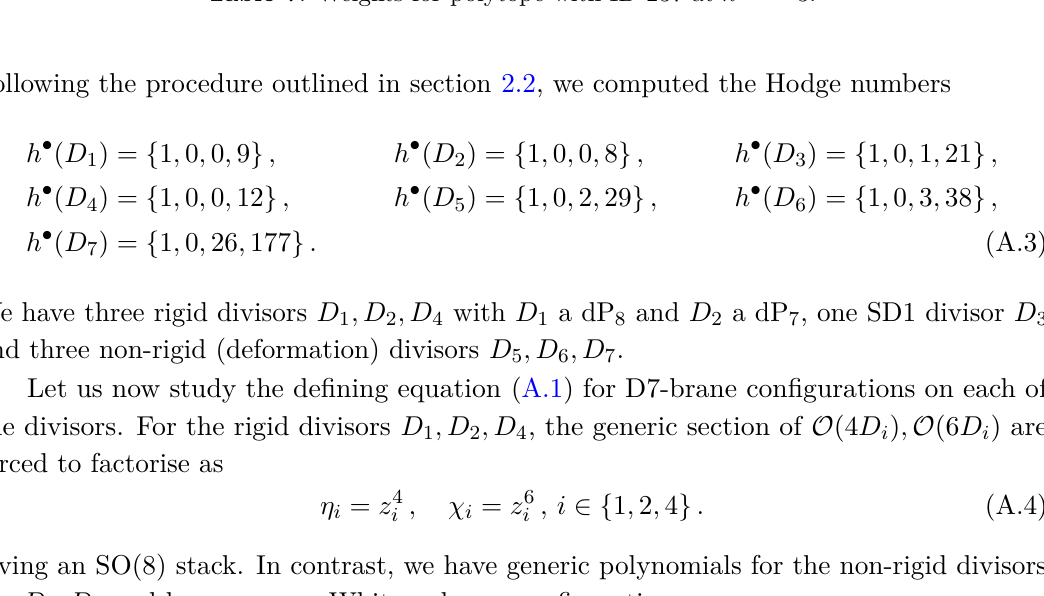
Table 7 . Weights for polytope with ID 237 at h 1 , 1 = 3